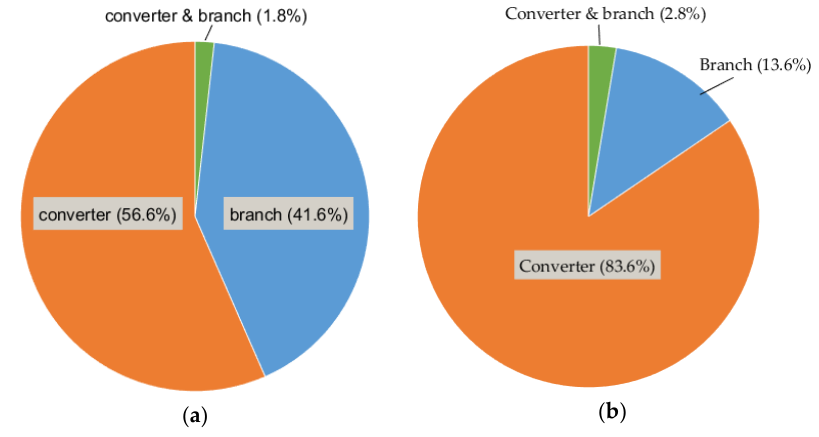
Figure 10. Shedding value per state on each DC bus.